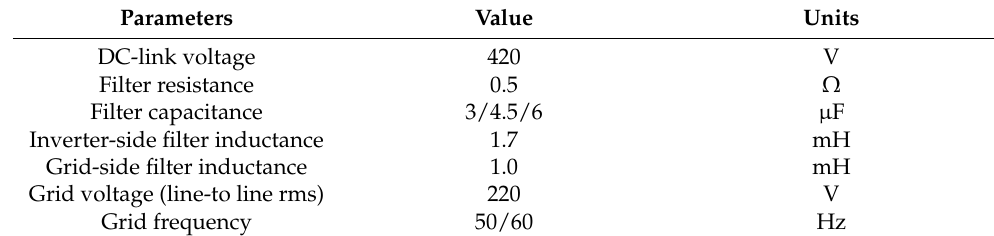
Table 1. System parameters of a three-phase GCI with LCL filter.